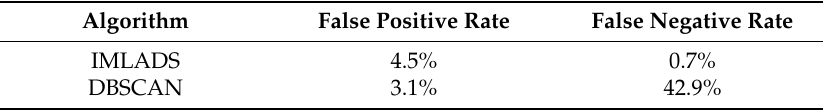
Table 6. The comparison between IMLADS and DBSCAN.